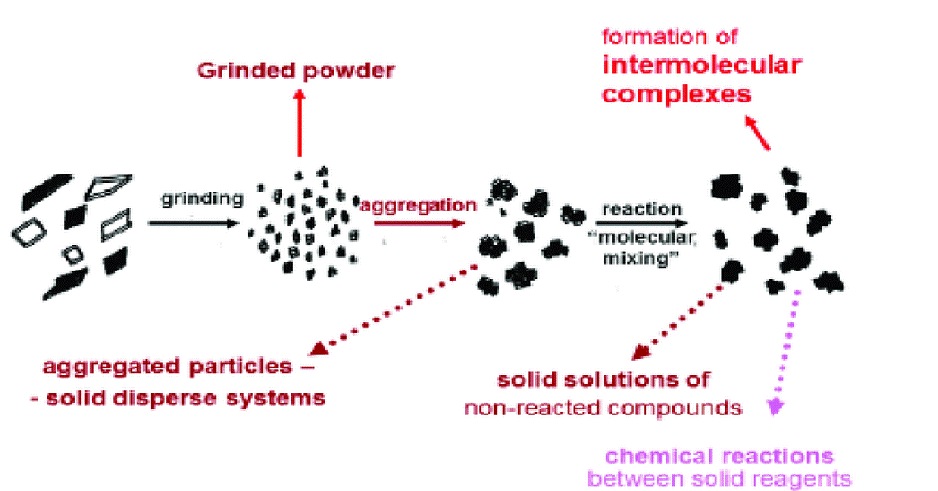
Figure 6. Scheme of mechanochemical transformations in mixtures of solids (drugs + excipients) during mechanochemical processing [57].